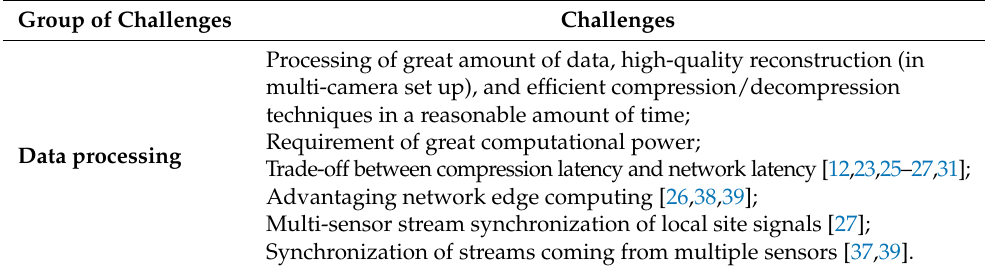
Table 3. Data processing, transmission, and scalability challenges. Group of